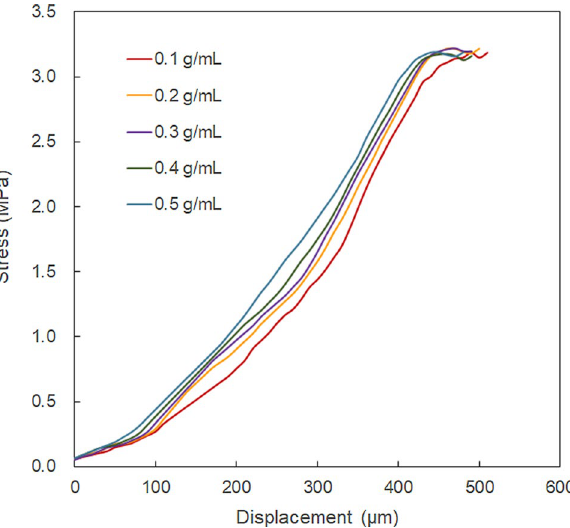
Figure 7. Mechanical properties of the CNF/PEGDA composite hydrogel microstructures at different concentrations of PEGDA. The concentration of CNF was fixed at 0.5 wt%.